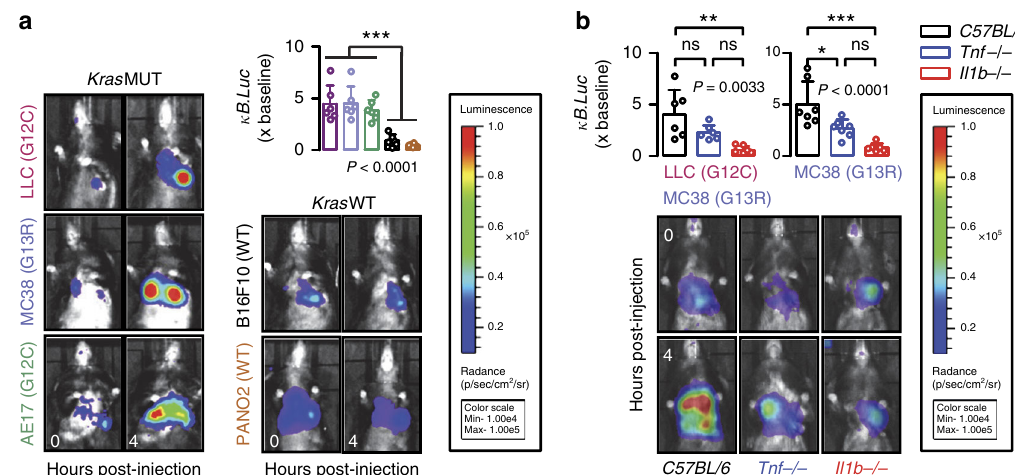
Fig. 3 Pleural IL-1 β activates NF- κ B in Kras -mutant tumor cells in vivo. Five different C57BL/6 mouse tumor cell lines with (LLC, MC38, AE17) or without (B16F10, PANO2) Kras mutations were assessed for inducible NF- κΒ activation in response to the pleural environment in vivo. a Representative bioluminescent images and data summary ( n = 6 mice/cell line) of C57BL/6 mice at 0 and 4 h after intrapleural injection of a million mouse tumor cells stably expressing pNGL . Note the marked induction of the bioluminescent signal emitted speci fi cally by Kras MUT cells after 4 h. Note also the diminishing signal emitted by Kras WT cells. b Representative bioluminescent images and data summary (LLC: n = 6 mice/genotype; MC38: n = 7 mice/genotype) of